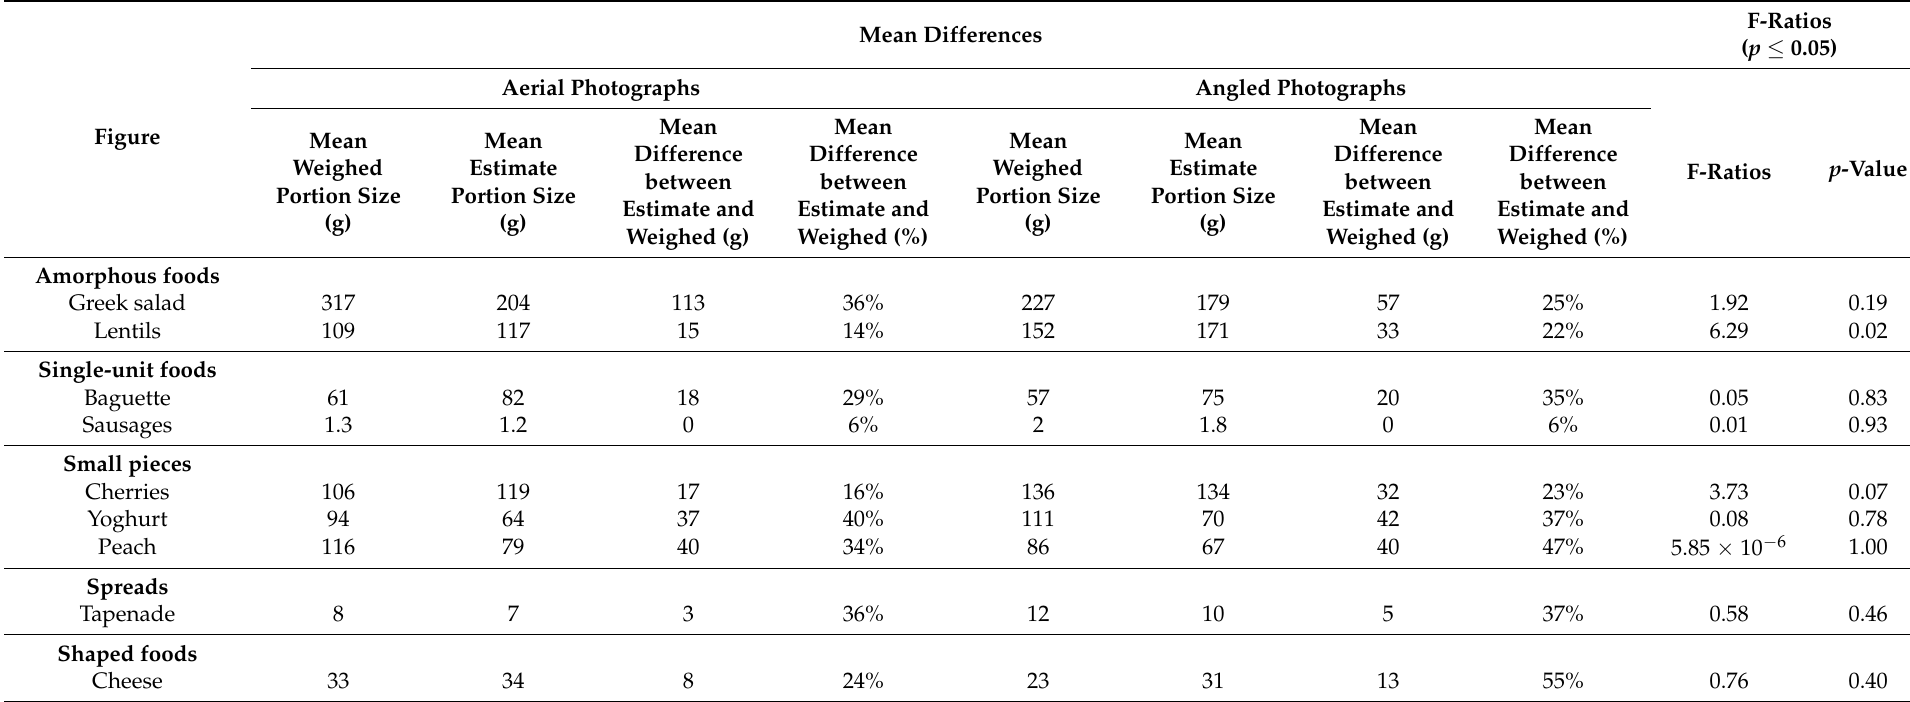
Mean Differences